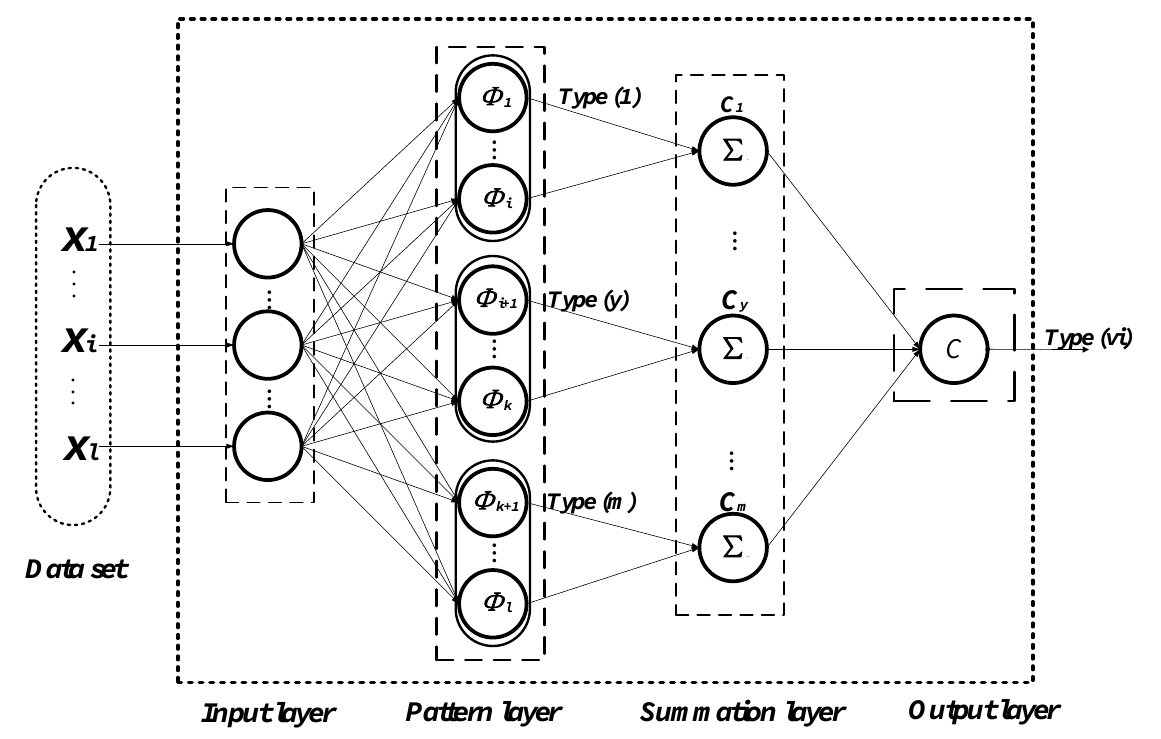
Figure 1. Probabilistic neural network structure